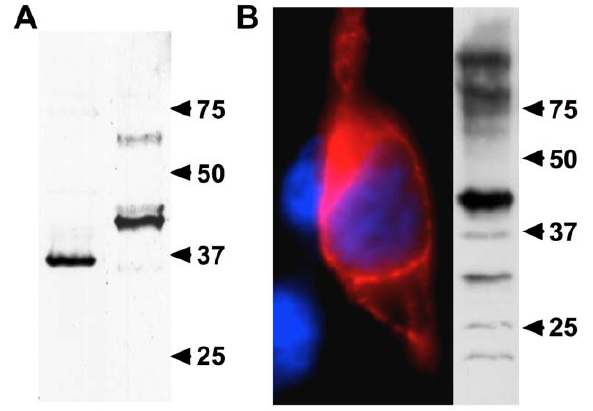
Figure 2. Expression of endogenous and recombinant acrop- sins. (A) Immunoblot of a total protein lysate obtained from adult A. palmata probed with anti-acropsin 1 ( , 36 kDa; Lane 1) and acropsin 2 ( , 40 kDa; Lane 2) antibodies. (B) Acropsin 2-1D4 chimera was expressed in HEK293t cells as described in Materials and Methods. Left panel: cells were fixed and stained with 1D4 monoclonal antibody (red) and DAPI (blue). Right panel: Western blot probed with 1D4 antibody. The 40 kDa band represents acropsin